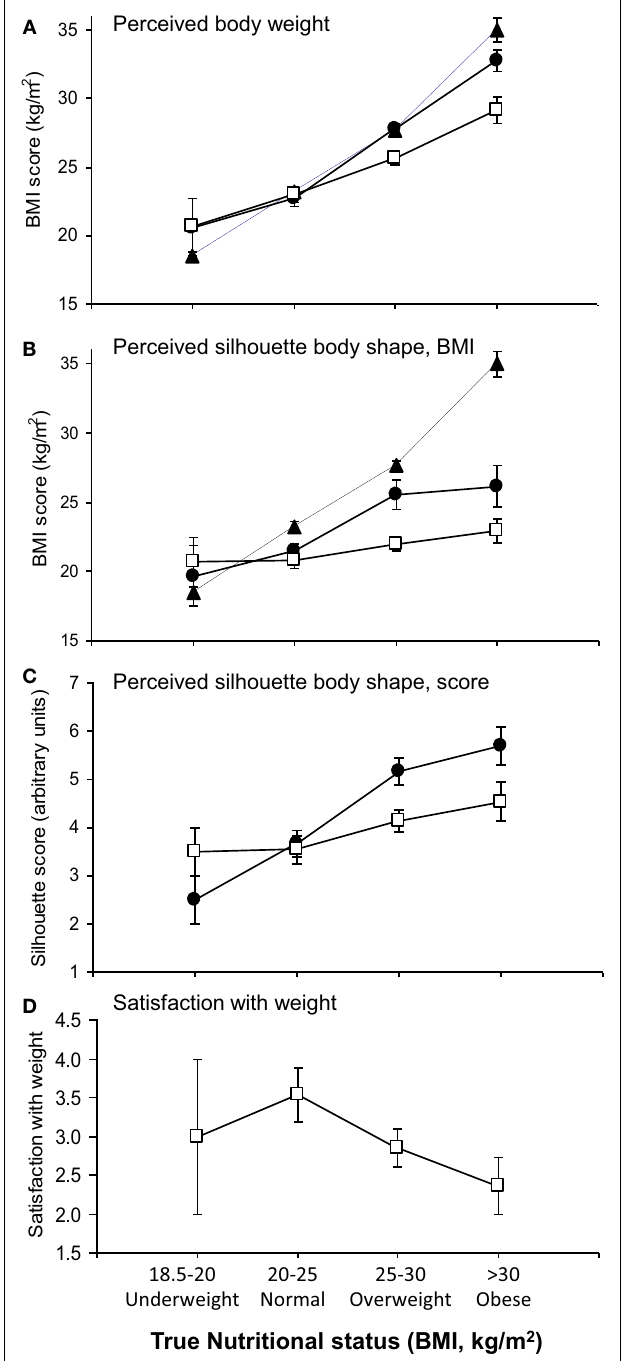
FIGURE 2 | Relationship of perceived and ideal body size to current nutritional status . (A) Perceived body weight:True (filled triangles, dashed line), usual (filled circles), and ideal (open squares) body weight, expressed in kilograms (normalized to BMI) of patients according to current nutritional status category. “True” represents measured values, and “Usual” and “Ideal” were derived from questionnaire responses. (B) Perceived body shape from silhouettes corresponding to known BMI values (Series A) compared to true BMI (filled triangles). Data are shown for perceived